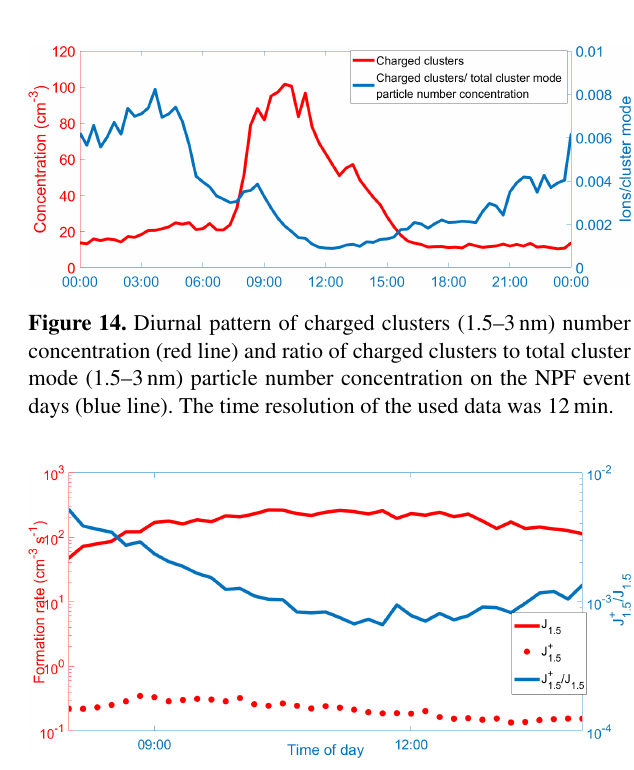
Figure 15. Diurnal pattern of formation rate of positive charged clusters of 1.5nm (red dots) and neutral clusters of 1.5nm (red line) and the ratio between them (blue line) on the NPF event days during the NPF time window we chose. The time resolution of the used data was 12min.